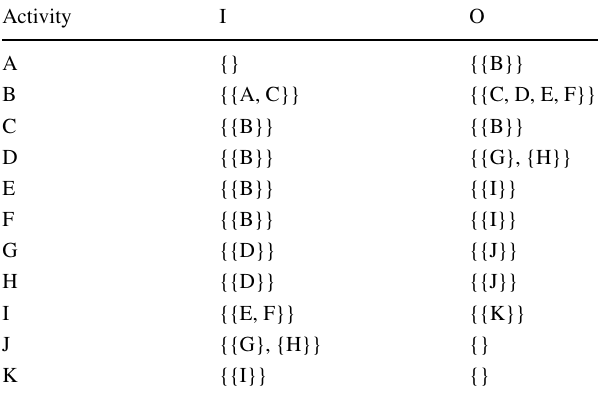
Table 1 The process model in Fig. 1 as a causal matrix